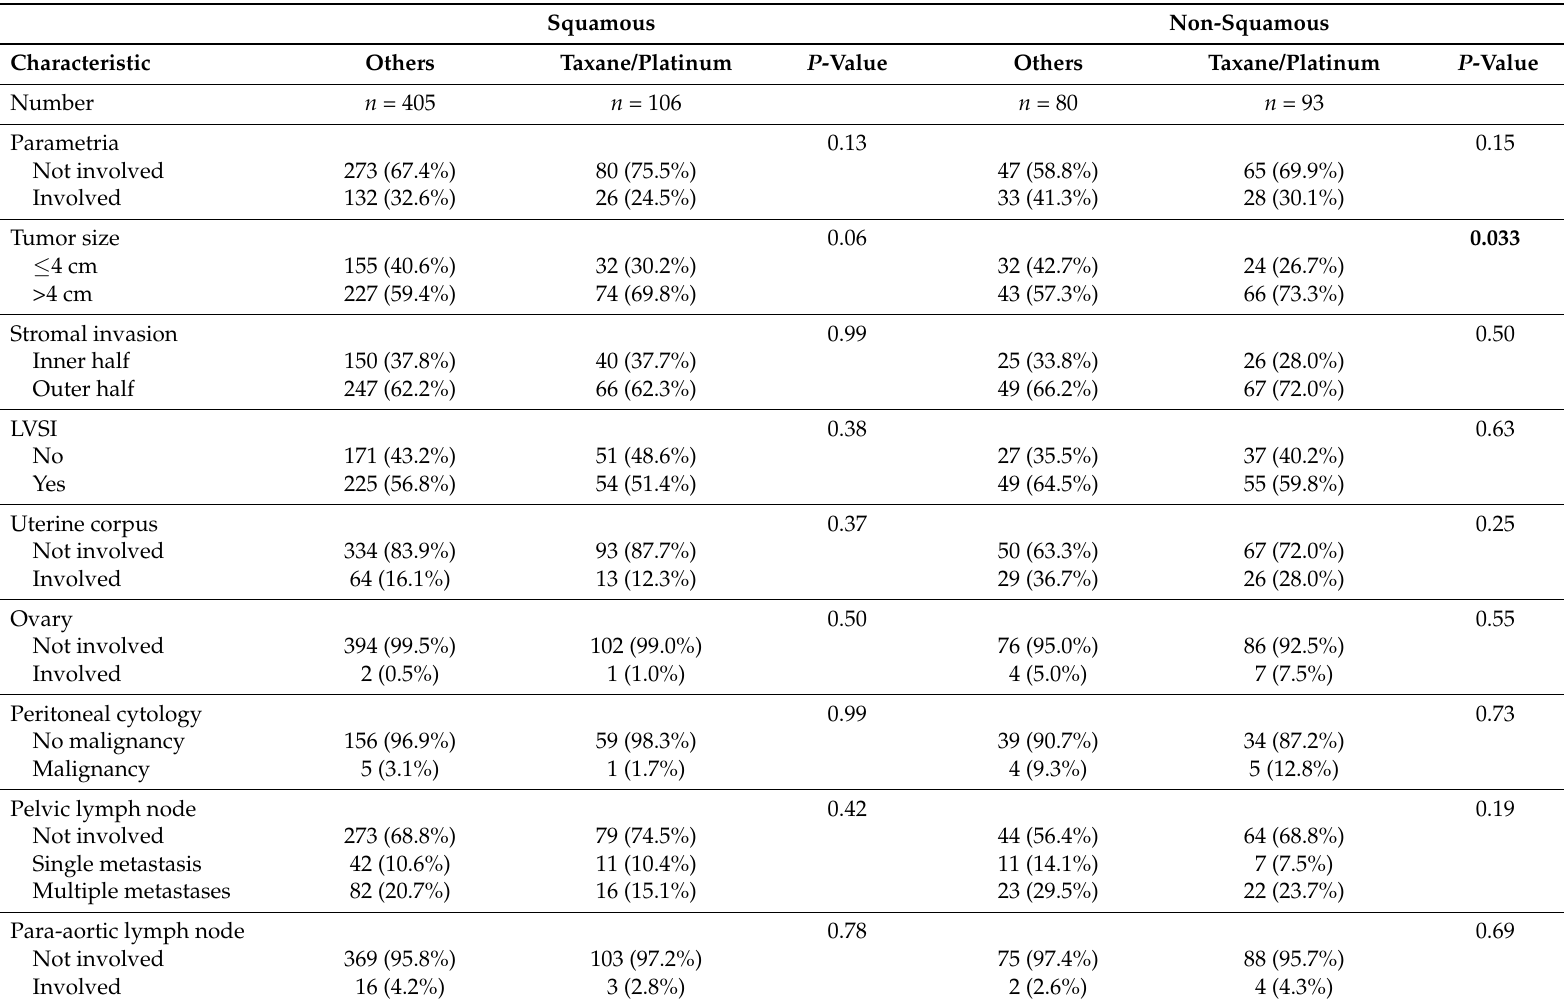
Table 3. Comparison of surgical-pathological factors per histology